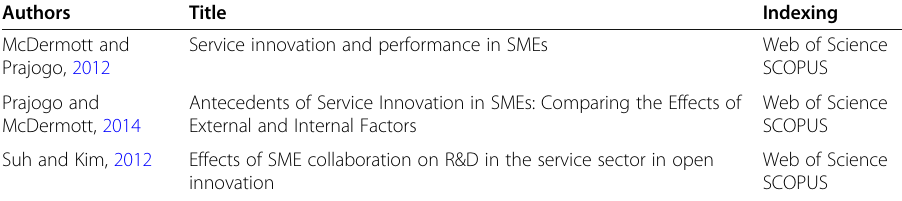
Table 2 Validation of the query's string by using a pre-established control group